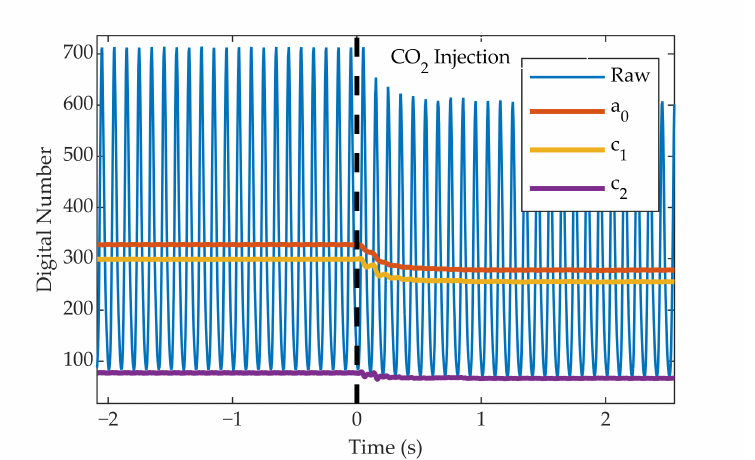
Figure 6. Signal measured by the camera when one of the gases is injected into the cell (in this case CO 2 ).